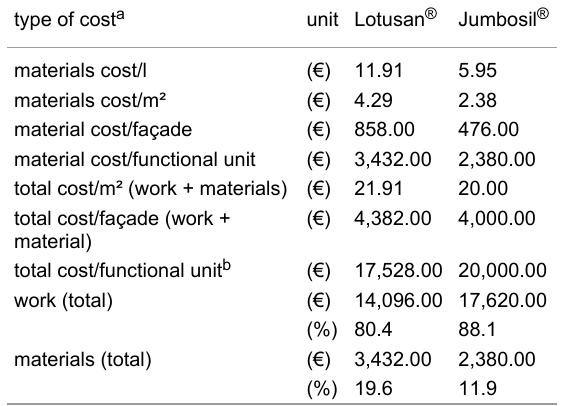
Table 1: Results for the calculation of cost based on retail prices. type of cost